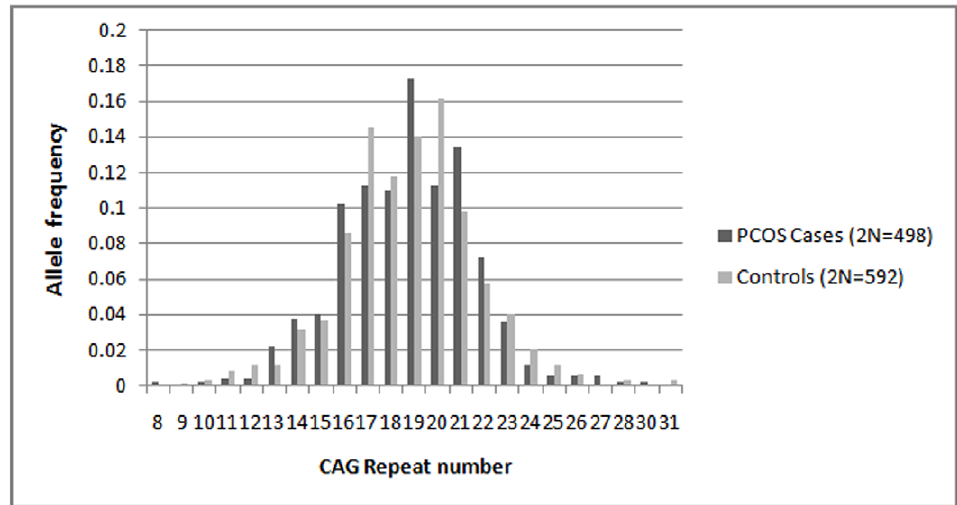
Figure 1. Distribution of CAG alleles in PCOS cases and controls.